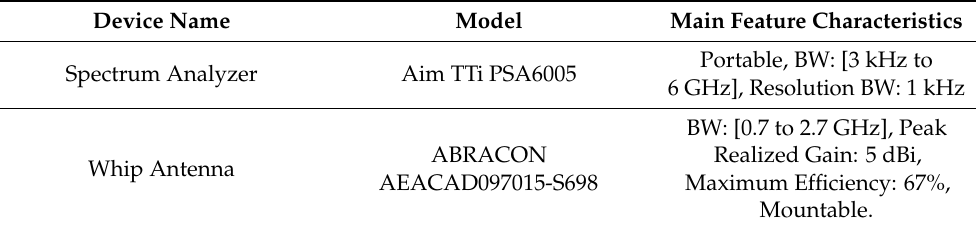
Table 1. RF spectral survey device